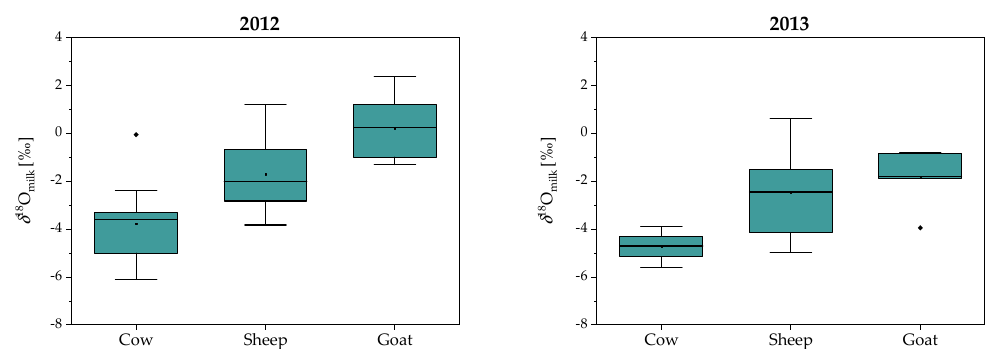
Figure 4. Box plot of the δ 18 O milk values of different species (cow, sheep, and goat), collected from farms located in Mediterranean (Brkini, Vipava), Dinaric (Karst) and Alpine region (Bovec) in May and June in 2012 and 2013.